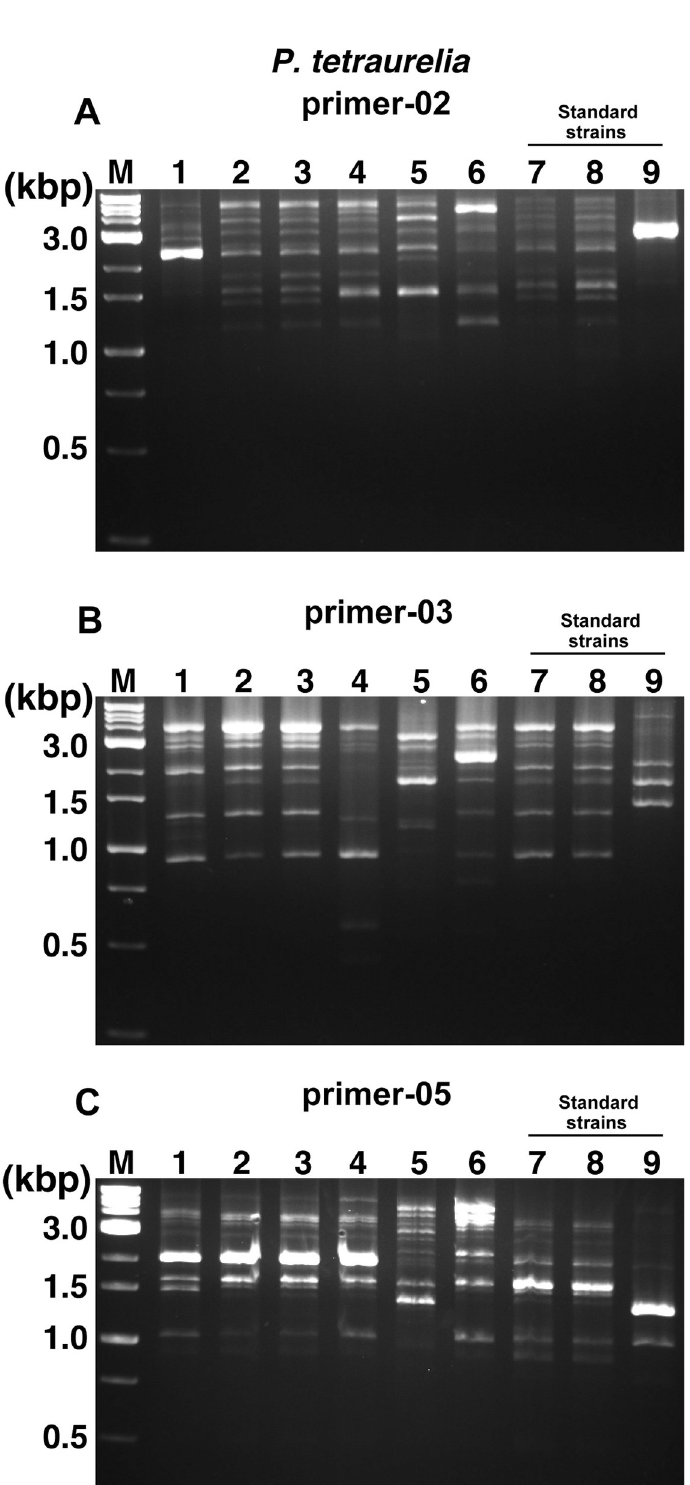
Fig 2. RAPD analysis using template DNA from P . tetraurelia strains. RAPD analysis using template DNA from 6 recommended strains (Nos. 1–6) and 3 standard strains (Nos. 7–9) of P . tetraurelia . The random primers used in each reaction are presented at the top of the figures (A, primer-02. B, primer-03. C, primer-05). M, weight marker.